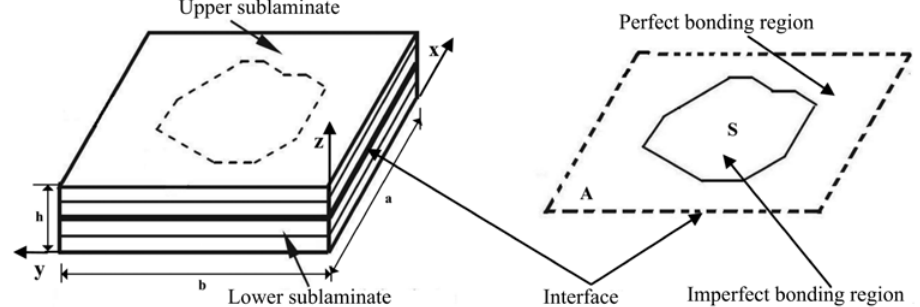
Figure 1 Geometry of an imperfect composite